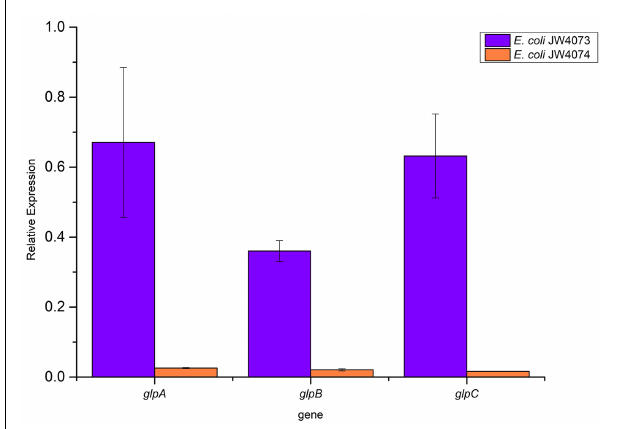
FIGURE 6 | Expression levels of glpA , glpB , and glpC in E. coli JW4073 and E. coli JW4074.